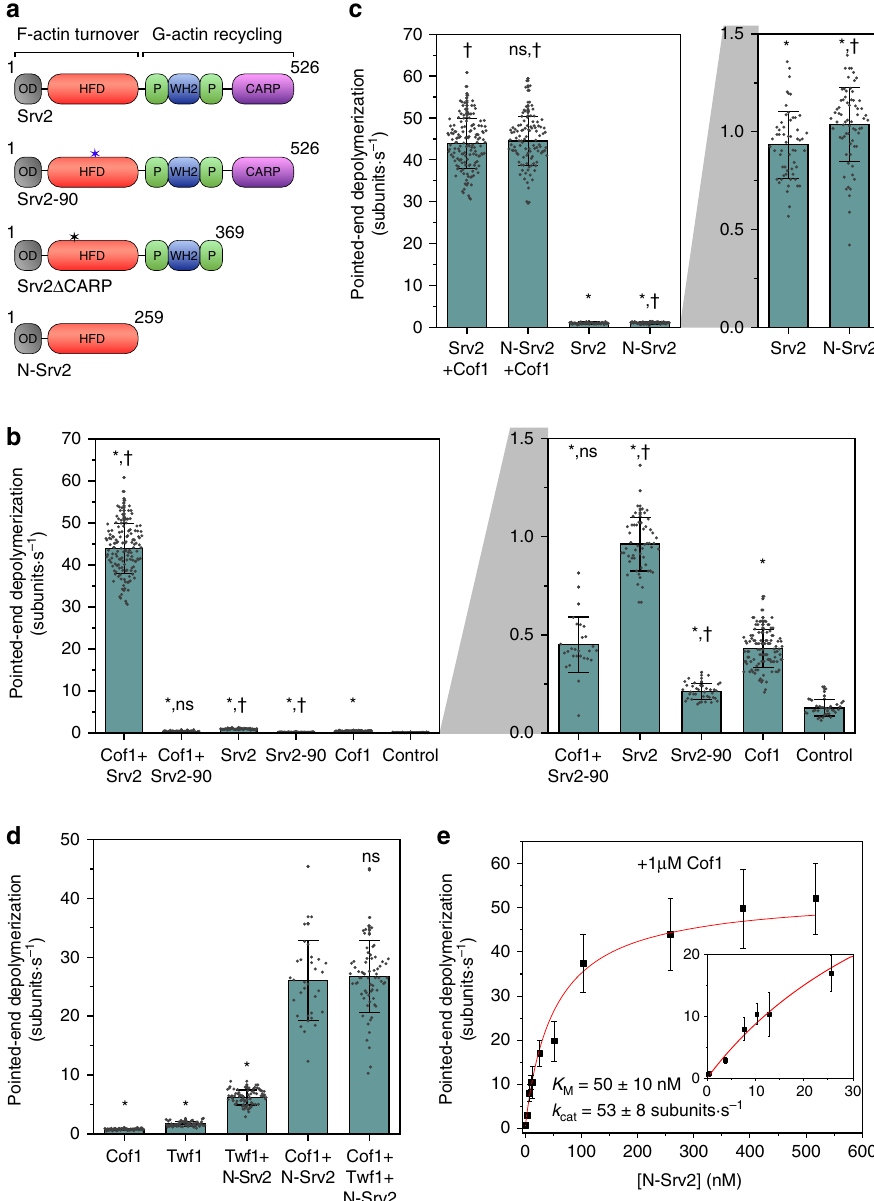
Fig. 2 Contributions of S. cerevisiae Srv2/CAP domains to its synergistic depolymerization with Co fi lin. a Domain diagram of Srv2 constructs used in this study. Blue asterisk indicates location of the Srv2-90 mutation. Black asterisk on Srv2 Δ CARP indicates the location of its single cysteine, which was used for Cy5- labeling. b Rates (±sd) of pointed-end depolymerization in the presence of 1 μ M Cof1 and/or 0.5 μ M Srv2 or Srv2-90. Right: Magni fi ed view. *statistical comparison by two-sample t test against Control ( p <0.05); † comparison with Cof1 ( p <0.05). ns no evidence for signi fi cance at p = 0.05. Srv2, Cof1 and Srv2- Cof1 data are the same as in Fig. 1e. Number of fi lament ends analyzed for each condition (left to right): 149, 28, 55, 38, 110 and 37. c Rates of pointed-end depolymerization in the presence of 1 μ M Cof1 and/or 0.5 μ M Srv2 or N-Srv2. *statistical comparison by two-sample t test against Srv2 + Cof1 ( p <0.05); † statistical comparison by two-sample t test against Srv2 ( p <0.05); ns no evidence for signi fi cance at p = 0.05 from Srv2 + Cof1 condition. Srv2 − Cof1 data are the same as in Fig. 1e. Number of fi lament ends analyzed for each condition (left to right): 149, 106, 57 and 68. d Rates of pointed-end depolymerization in the presence of 1 μ M Cof1, 1 μ M Twf1 and 160nM N-Srv2 alone or in stated combinations. *statistical comparison by two-sample t test against Cof1 + N-Srv2 ( p < 0.05). ns no evidence for signi fi cance at p = 0.05. Number of fi lament ends analyzed for each condition (left to right): 68, 61, 77, 33, and 70. e Rates (±sd) of pointed-end depolymerization as a function of N-Srv2 concentration in presence of 1 μ M Cof1. N = 32 – 262 fi laments analyzed per concentration. Fit to the Michaelis − Menten equation (red) yielded K M = 50±10nM; k cat = 53±8 subunits s − 1 . Inset: magni fi ed view. Source data are provided as a Source Data fi le. All experiments were performed at least three independent times, and yielded similar results. Data shown are from one